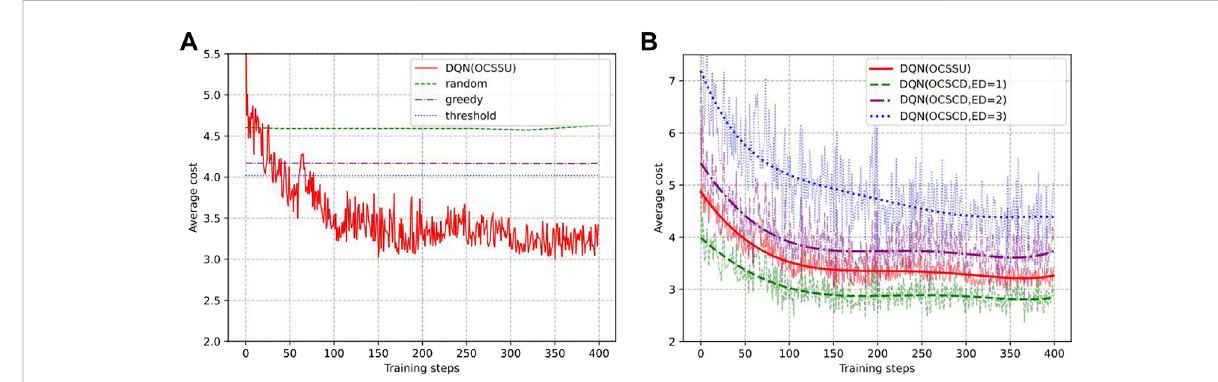
FIGURE 10 Comparison of performances between different policies. DQN (historical channel state) denotes the historical channel state used in decision- making; DQN(ED = x ) denotes that channel state detection is performed at the beginning of each time slot; and x units of energy are consumed for each channel detection. (A) shows the comparison between the DQN (historical channel state) algorithm and baseline policies. (B) shows the comparison of two different channel state detection schemes and different channel detection energy costs.